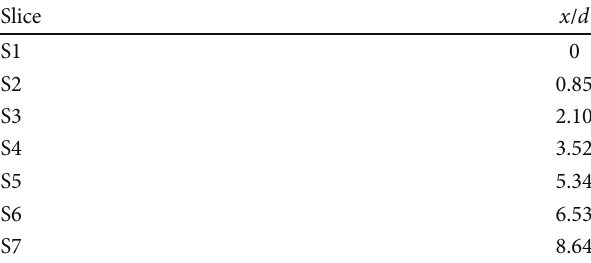
Table 4: Slice location